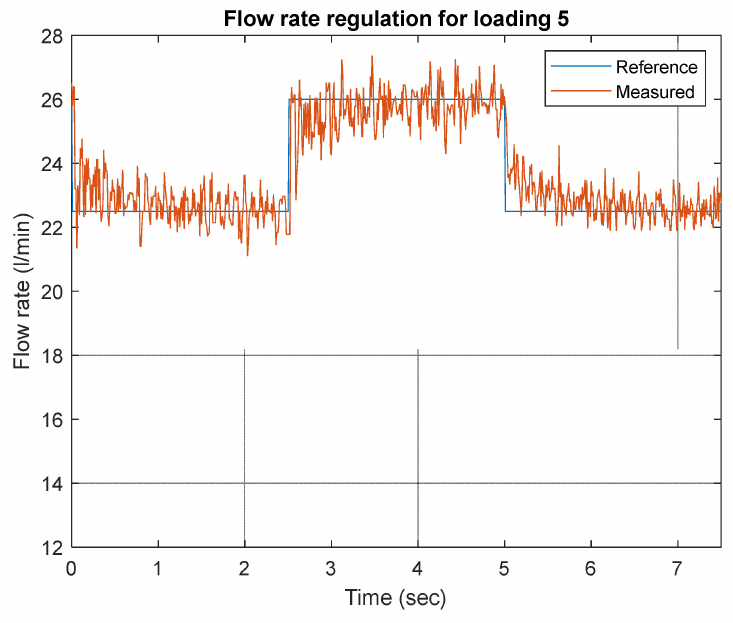
Figure 17. Experimental output flow rate data–loading 5.